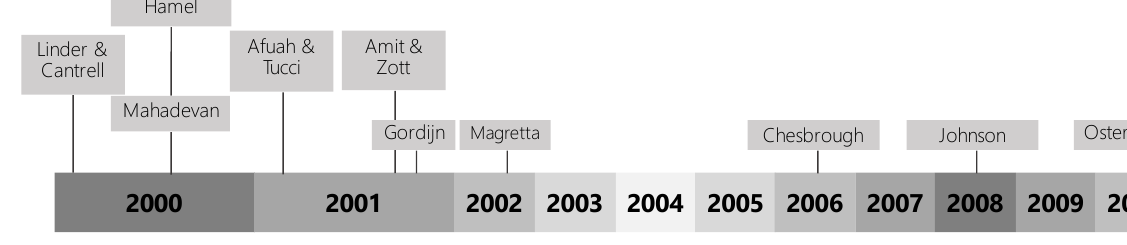
Figure 3. Author’s Timeline.